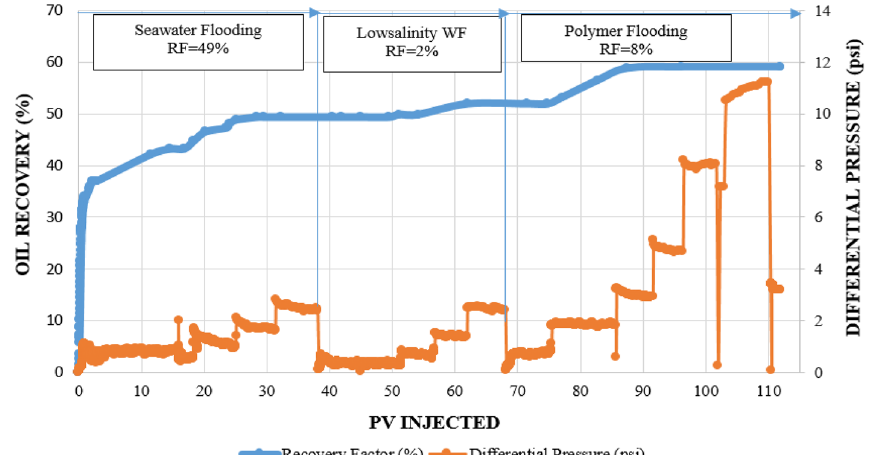
Fig. 9 RF and RRF data as a function of flow rates in cc/min during Exp. 2